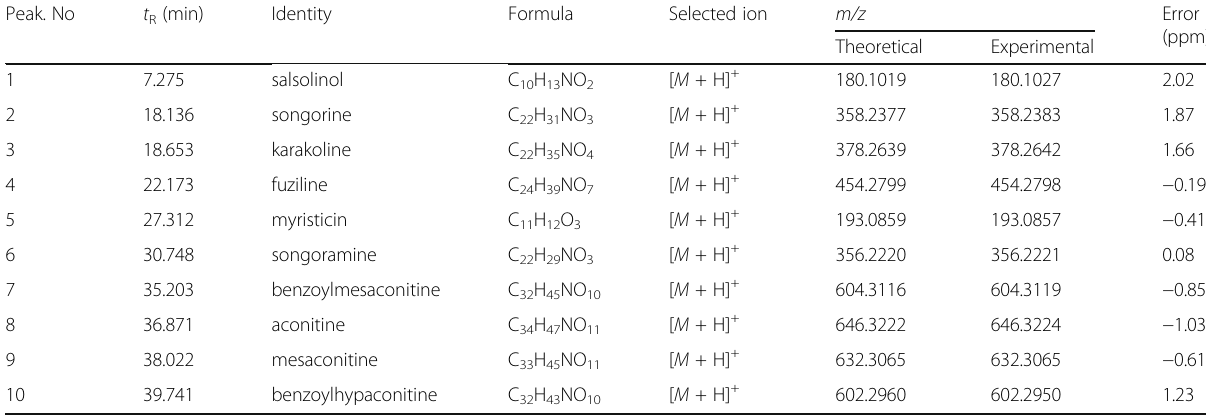
Table 2 Detection of Dai-Huang-Fu-Zi-Tang in positive ion mode Peak. No t R (min) Identity Formula Selected ion m/z Error